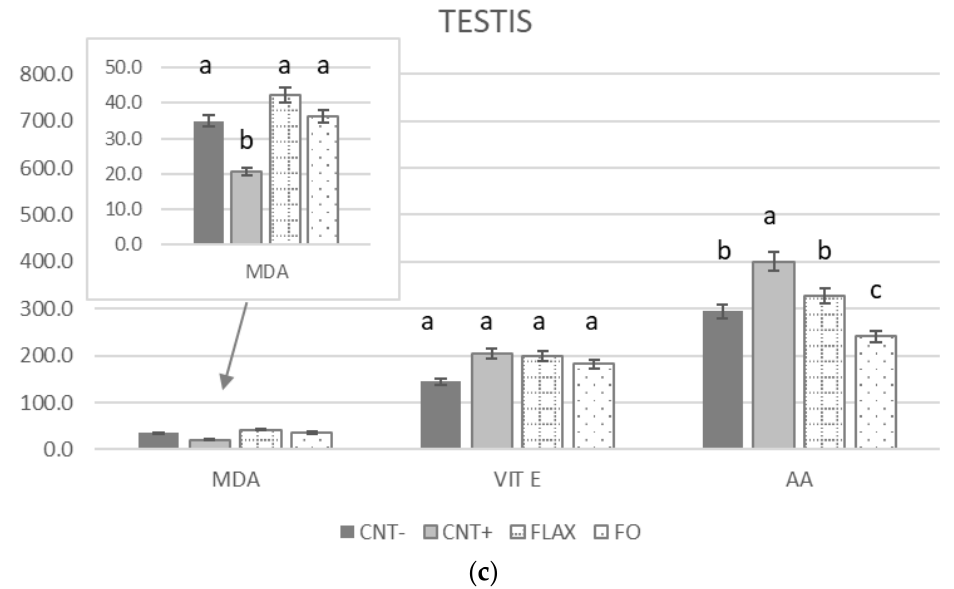
Figure 1. The effect of experimental diets on the oxidative status (malondialdehyde (MDA), nmol/g) and non-enzymatic antioxidant (vitamin E, ng/g, and ascorbic acid (AA), nmol/g) content of rabbit ( a ) liver, ( b ) brain, and ( c ) testis. When values differences were too wide to show a complete graph, a support window was added to the main one. The bars represent least squares means + 95% upper and lower limits. The letters a – c indicate a significant difference between dietary groups ( p < 0.05, Bonferroni post hoc test).